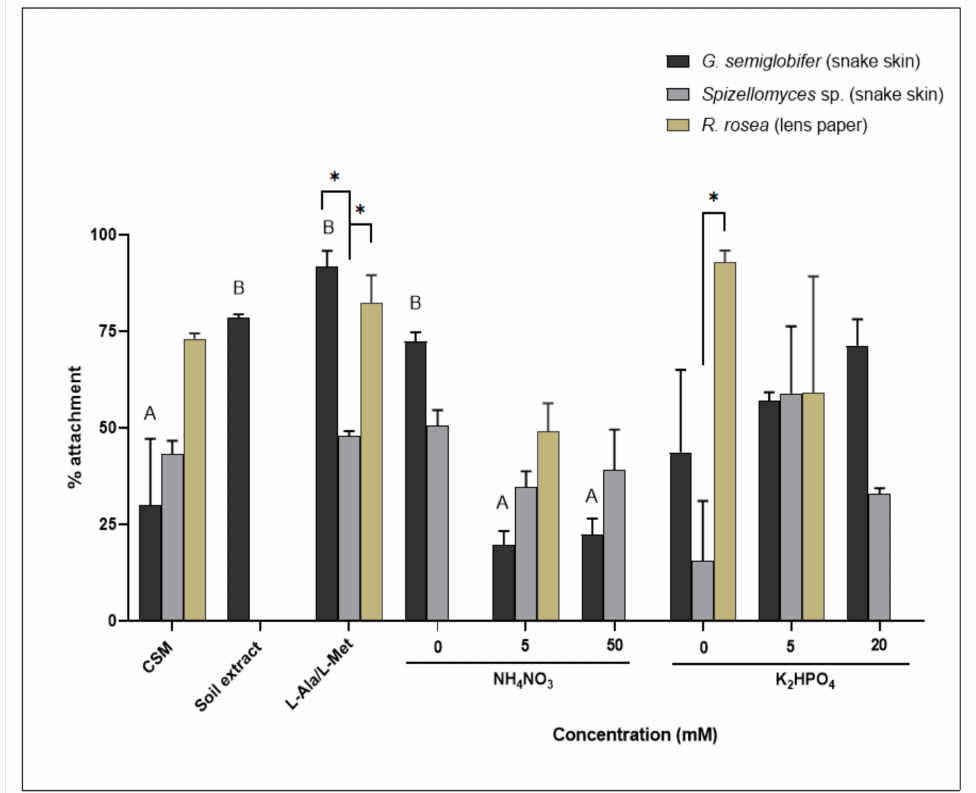
Figure 6. Percentage attachment of chytrid sporangia to baits (snake skin or lens paper). Error bars are SEM. Significant differences were observed between the nitrogen treatments (F 5, 36 = 32.19, p < 0.05) and denoted by capital letters (A, B), but no significant changes were found in the phosphate series (F 4, 30 = 3.343, p > 0.05). Significance found between isolates (F 2, 36 = 18.08, p < 0.05) is denoted by an asterix ( ∗